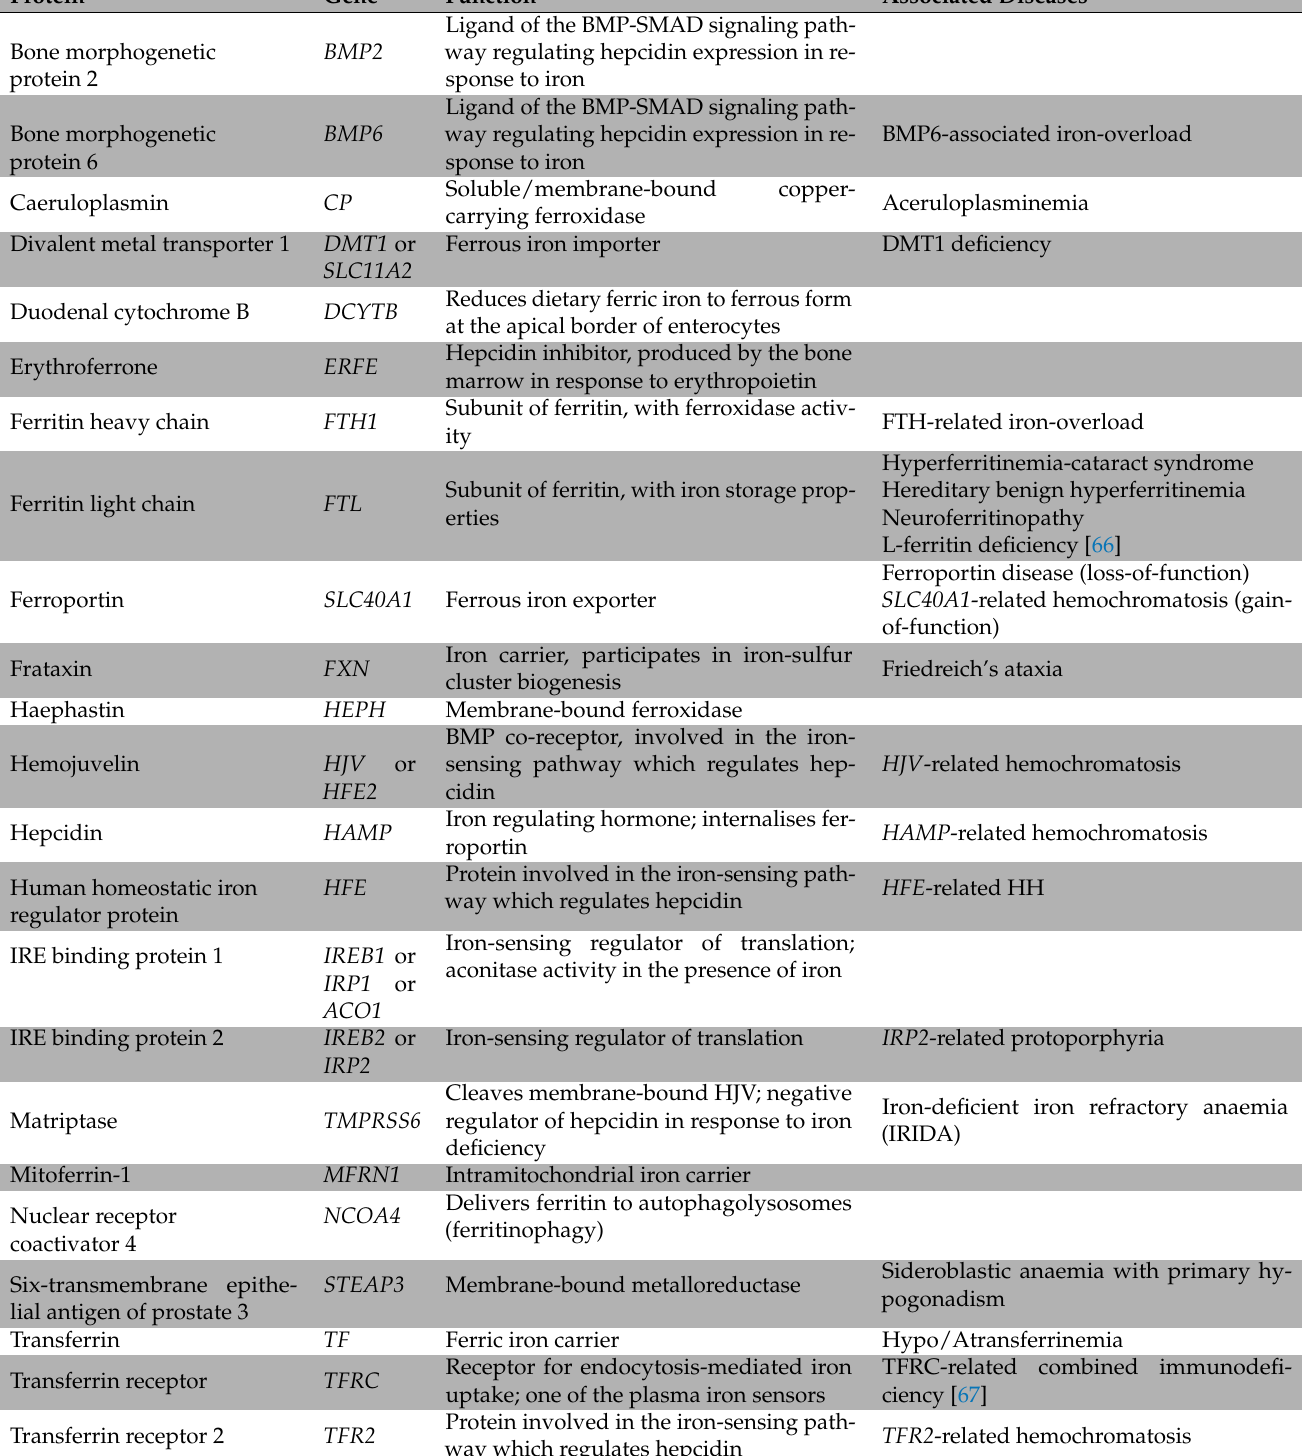
Table 1. Main actors of iron metabolism in